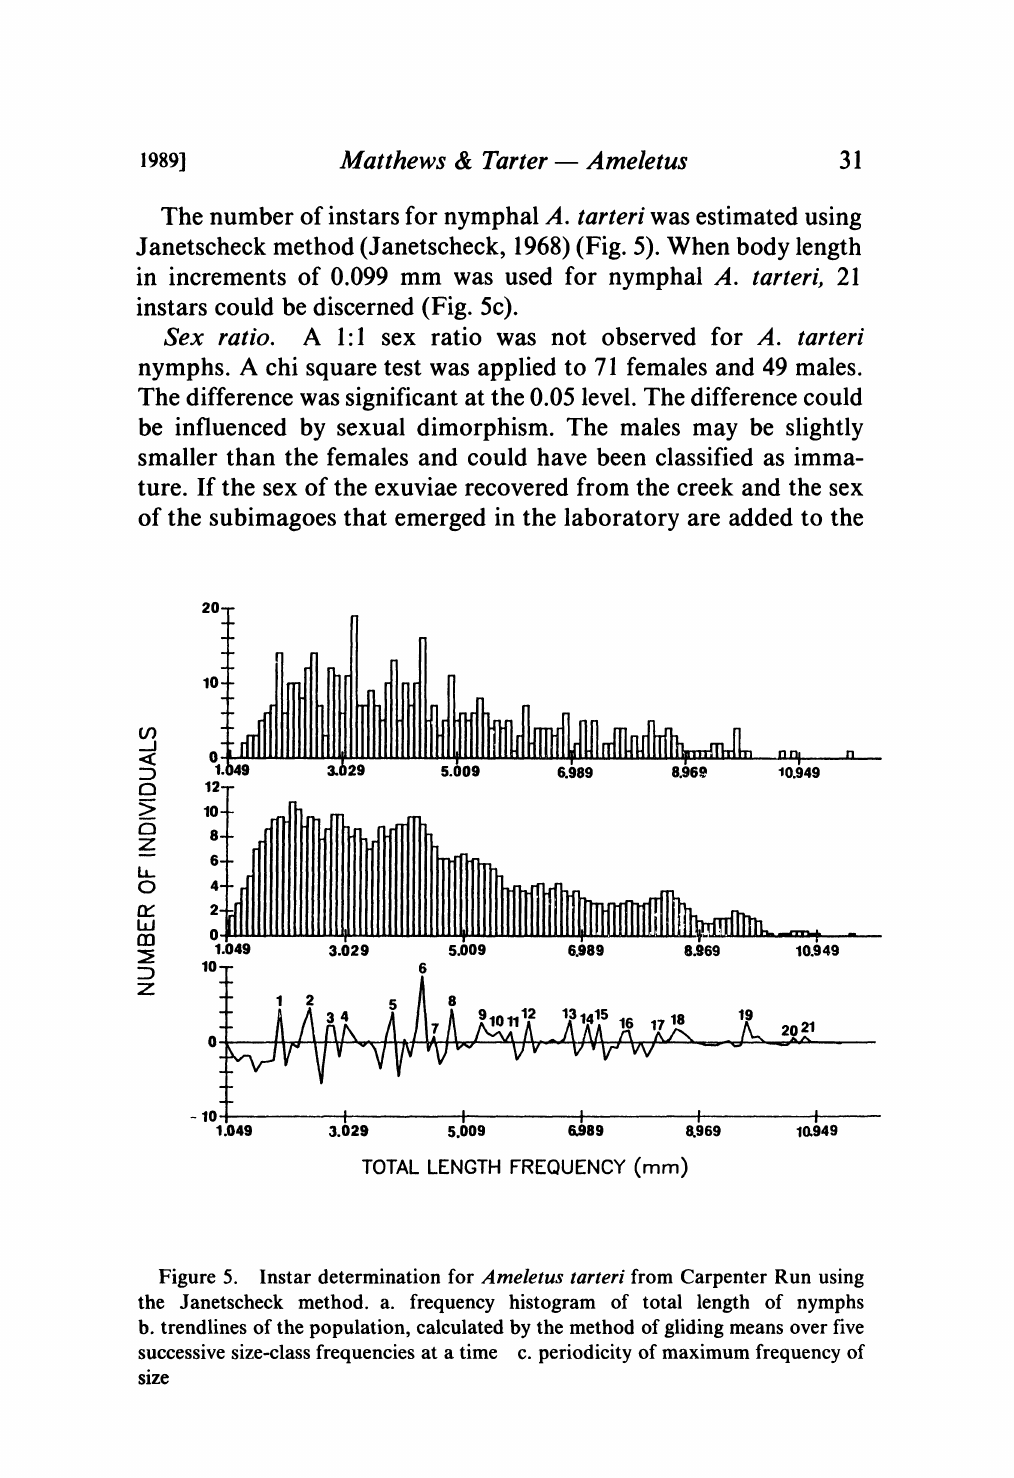
Figure 5. Instar determination for Ameletus tarteri from Carpenter Run using the Janetscheck method, a. frequency histogram of total length of nymphs b. trendlines of the population, calculated by the method of gliding means over five successive size-class frequencies at a time c. periodicity of maximum frequency of